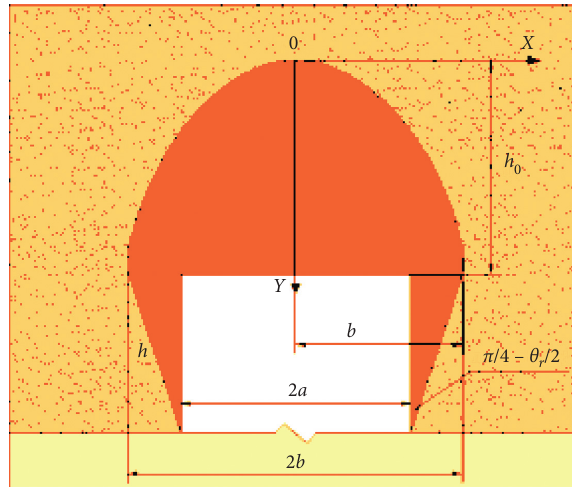
Figure 10: Roof leakage of a roadway with loose surrounding rock.